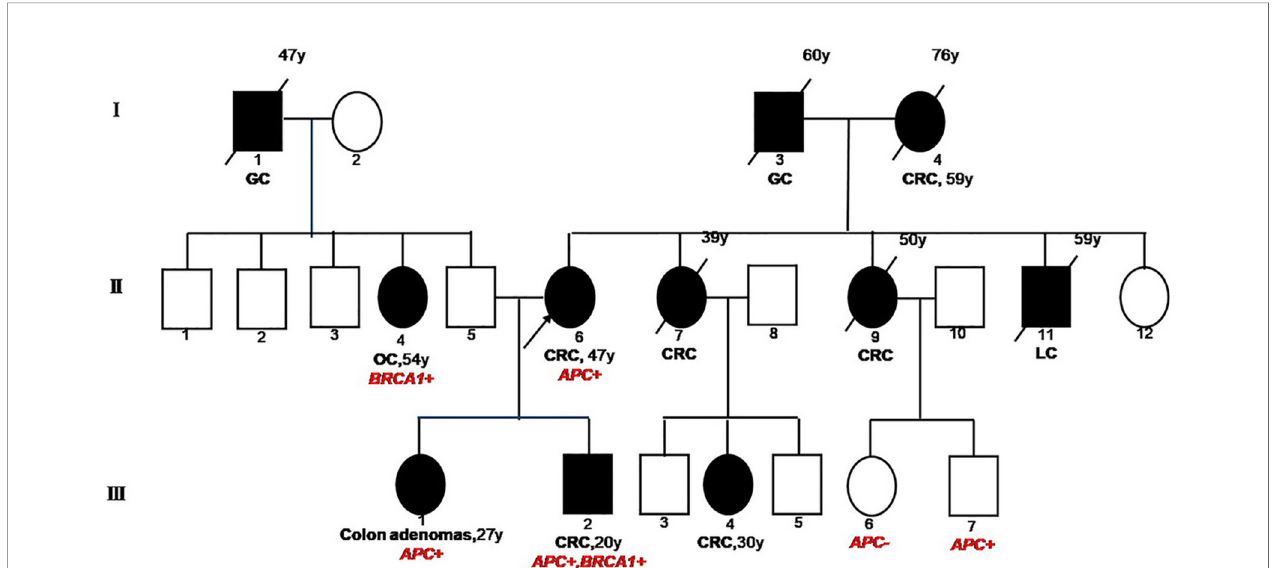
FIGURE 1 | Familial Pedigree of case. The proband is indicated by an arrowhead. Squares represent males, circles represent females. Solid symbols represent affected individuals. Symbols with slash indicate deceased individuals. Age at cancer diagnosis is reported following the corresponding disease and the age of death is reported on the top right corner of symbol. GC, gastric cancer; CRC, colorectal cancer; OC, ovarian cancer; LC, lung